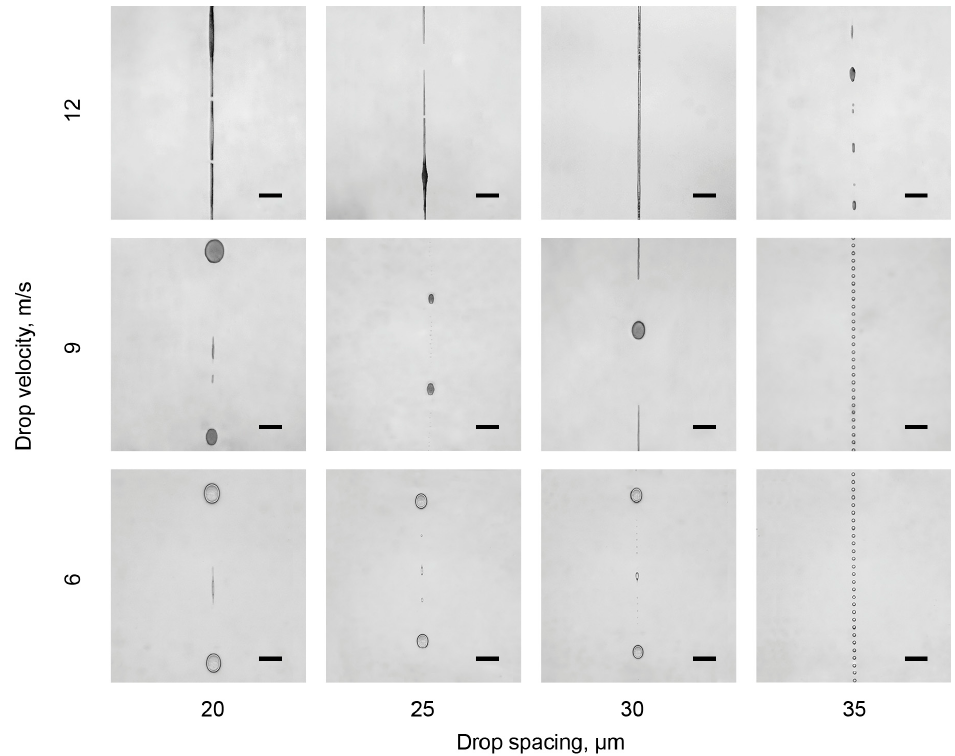
Figure A3. Array of optical images of a 1 pxl line printed on PDMS when cured for 5 min at 80 °C depending on drop spacing and velocity. The scale bar is 100 µm.